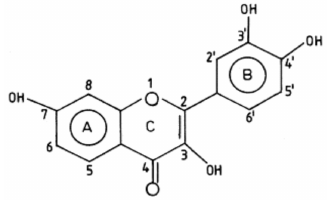
Figure 4. Chemical structure of